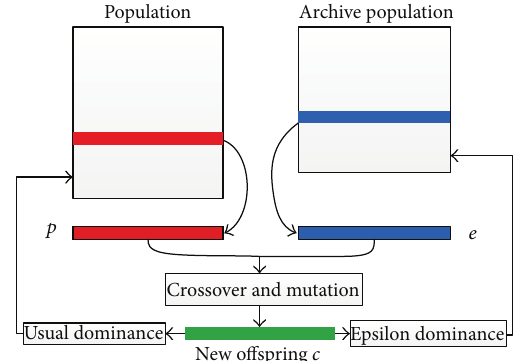
Figure 1: 𝜀 -MOEA